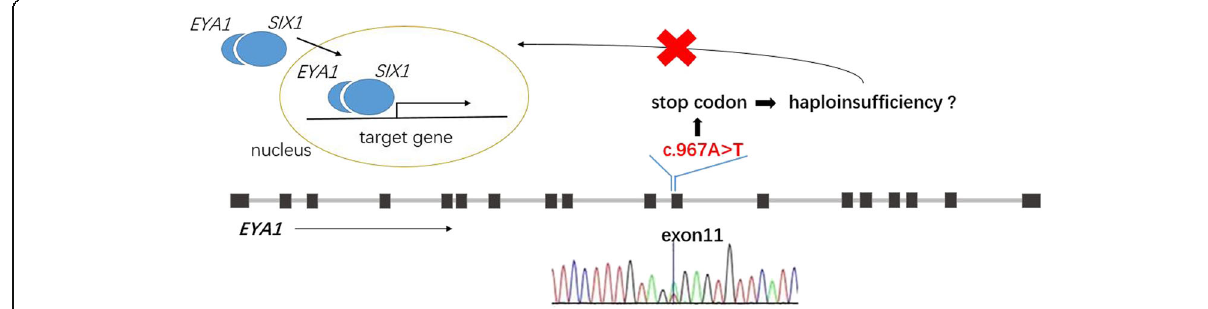
Fig. 7 Mutation in EYA1 exon 11 generates a stop codon. The haploinsufficiency of normal EYA1 disrupts SIX1 binding, which is necessary for the activation of target